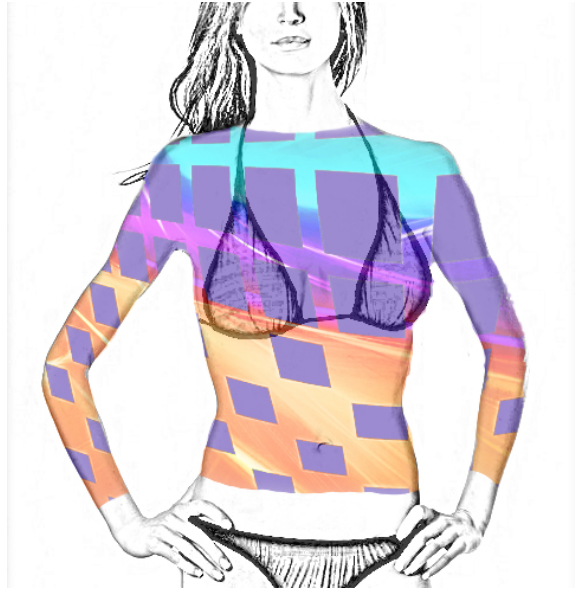
Figure 1. An example of projected digital clothes covering the body of a